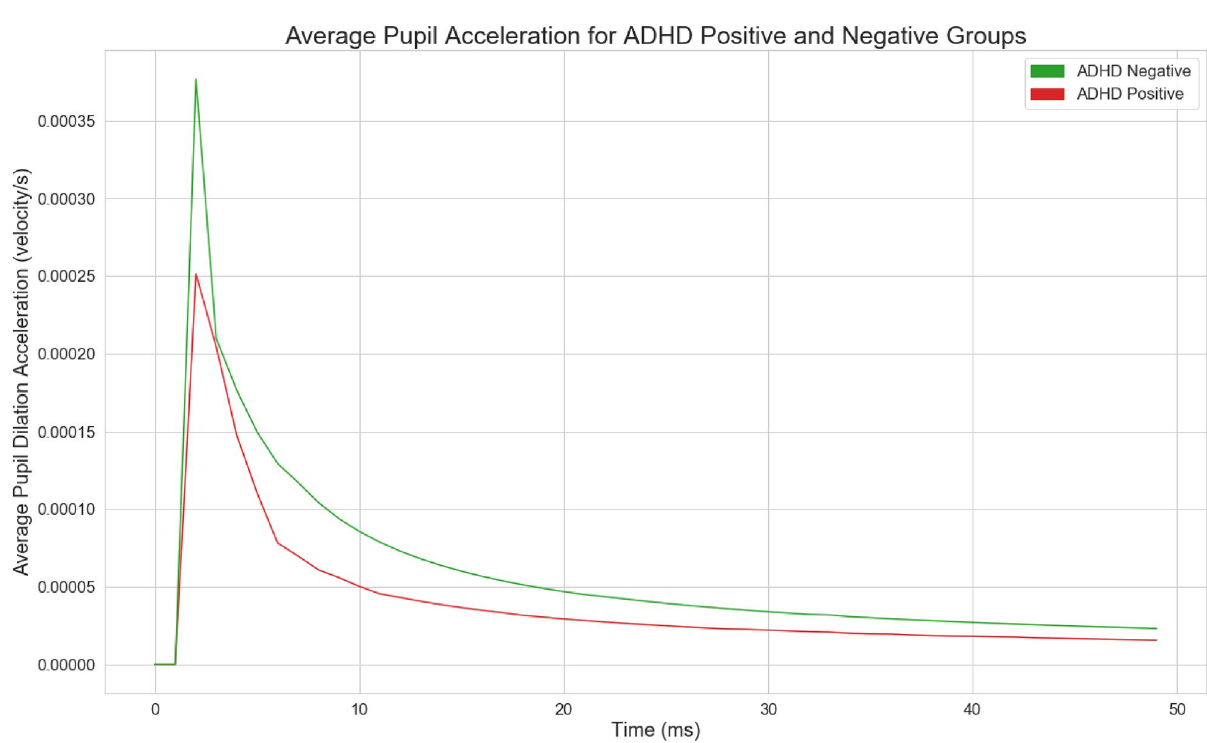
Figure 3. Pupil size dilation acceleration following the presentation of a